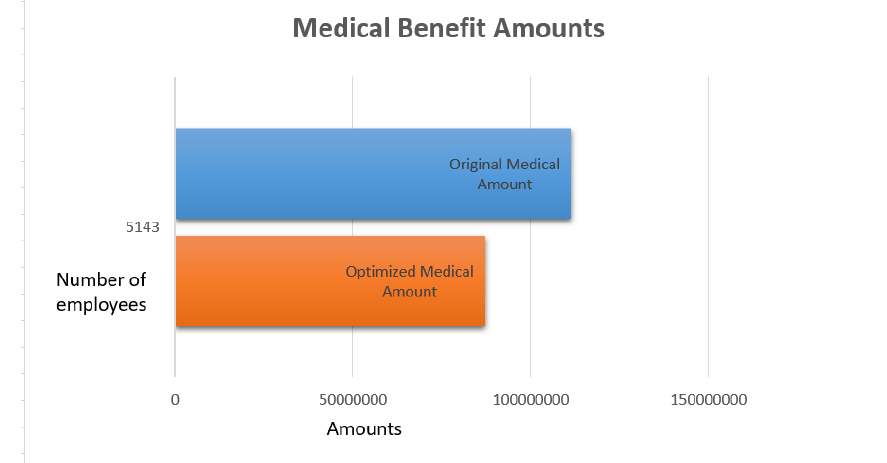
Figure 7. Total Medical Amount Comparison.